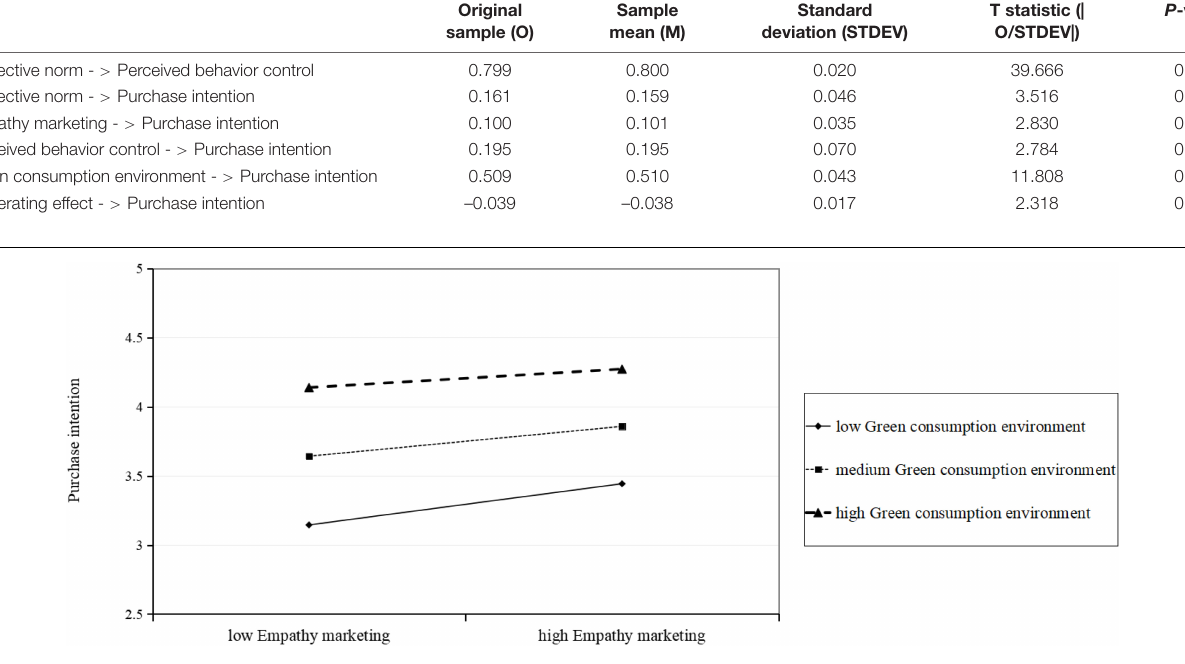
deviation (STDEV) coefficient is 0.056, the T statistic is 2.768, above 2.58, and the P -value of each indirect path is less than